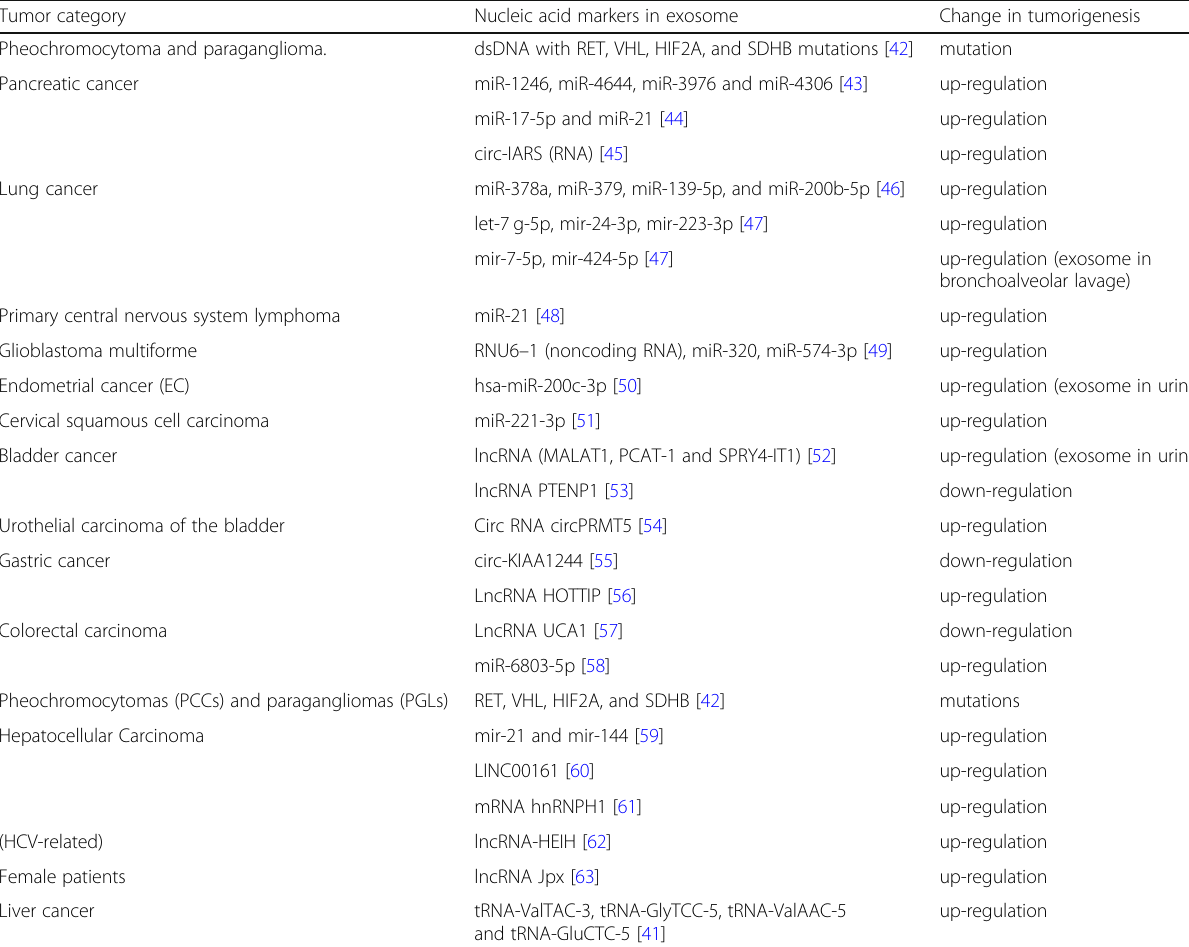
Table 2 Nucleic acid biomarkers in exosome for tumor diagnosis Tumor category Nucleic acid markers in exosome Pheochromocytoma and paraganglioma.